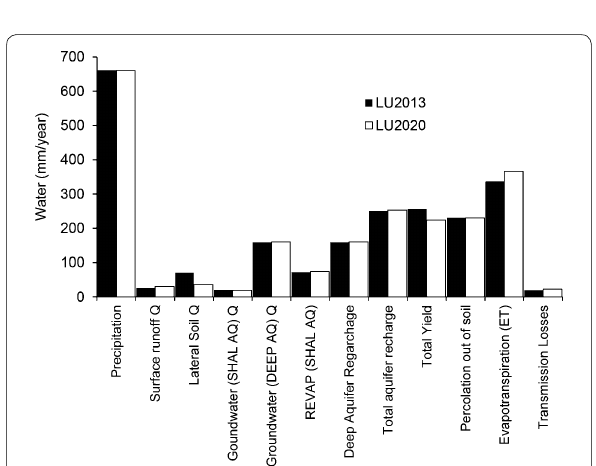
Fig. 19 Water balance of Ndembera watershed under 2013 and 2020 land use/cover scenarios